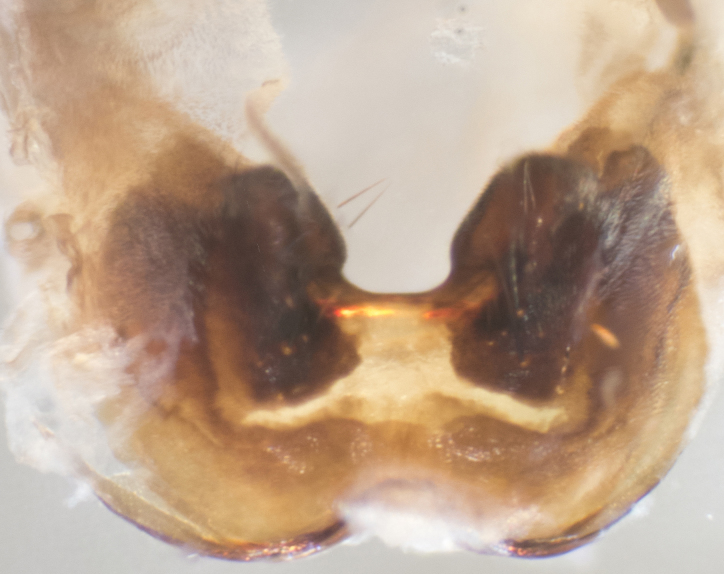
sternite 5, ventral view